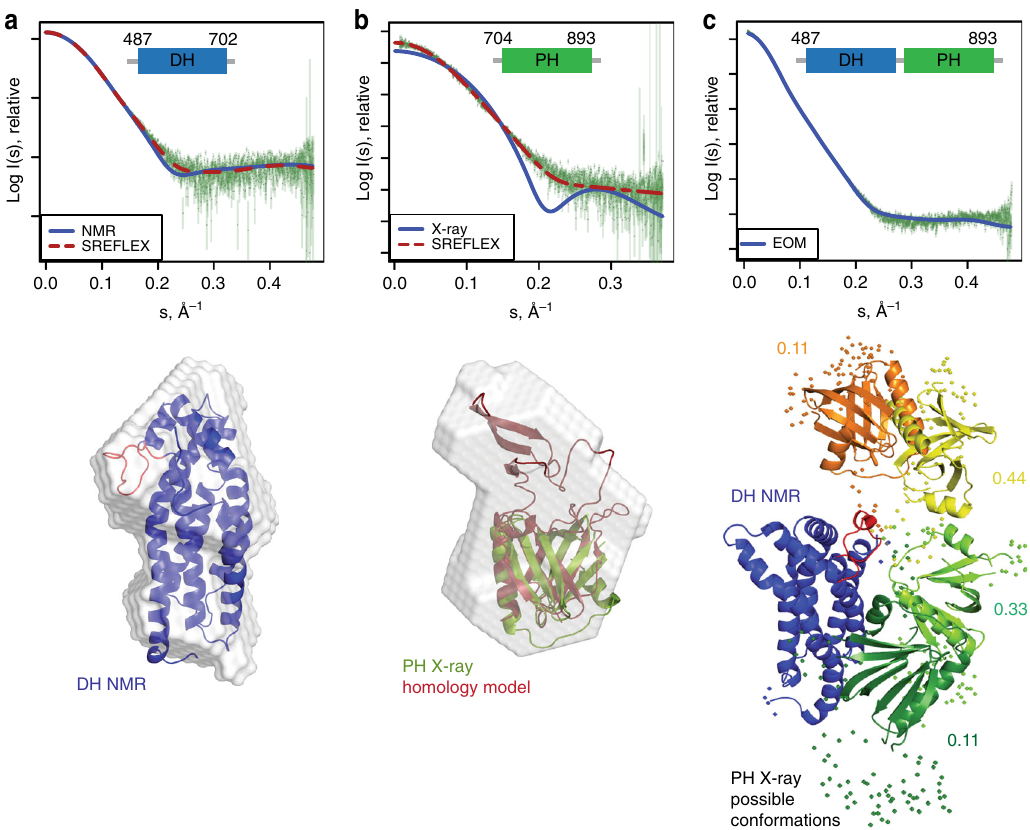
Fig. 3 Small-angle X-ray scattering (SAXS) of the DH – PH tandem domain. a Experimental SAXS pro fi le of the DH domain (green dots) and theoretical scattering pro fi les for the NMR model (discrepancy χ 2 = 1.5) and SREFLEX re fi ned model (discrepancy χ 2 = 1.0). Below, the DH domain NMR structure is superimposed with the SAXS ab initio model as gray envelope. The α 4 – α 5 loop is highlighted in red. b Experimental SAXS pro fi le of the PH domain (green dots) and theoretical scattering pro fi les of PH crystal structure (blue, discrepancy χ 2 = 8.1), as well as a re fi ned model for the full-length PH domain (red, discrepancy χ 2 = 1.1). Modeling of the full-length PH domain was based on a homology model with Xpln as a template (PDB ID 2Z0Q). For the PH domain, the SAXS based ab initio model is shown superimposed with the re fi ned model for the full-length PH domain (red) and the PH Δ 770 – 829 crystal structure (green). c Experimental SAXS pro fi le of the DH – PH domain (green dots) and theoretical scattering of a representative solution ensemble after EOM (blue, discrepancy χ 2 = 1.0). Possible conformations of the DH – PH tandem domain are shown after superposition on the DH domain (blue). The respective orientations of the PH domain are represented in orange, yellow, light, and dark green, and the fractions for the respective PH domain positions are indicated next to the structures illustrating the inter-domain fl exibility. Regions without high-resolution structural data, including the DH – PH linker and the internal PH deletion 770 – 829, are shown as